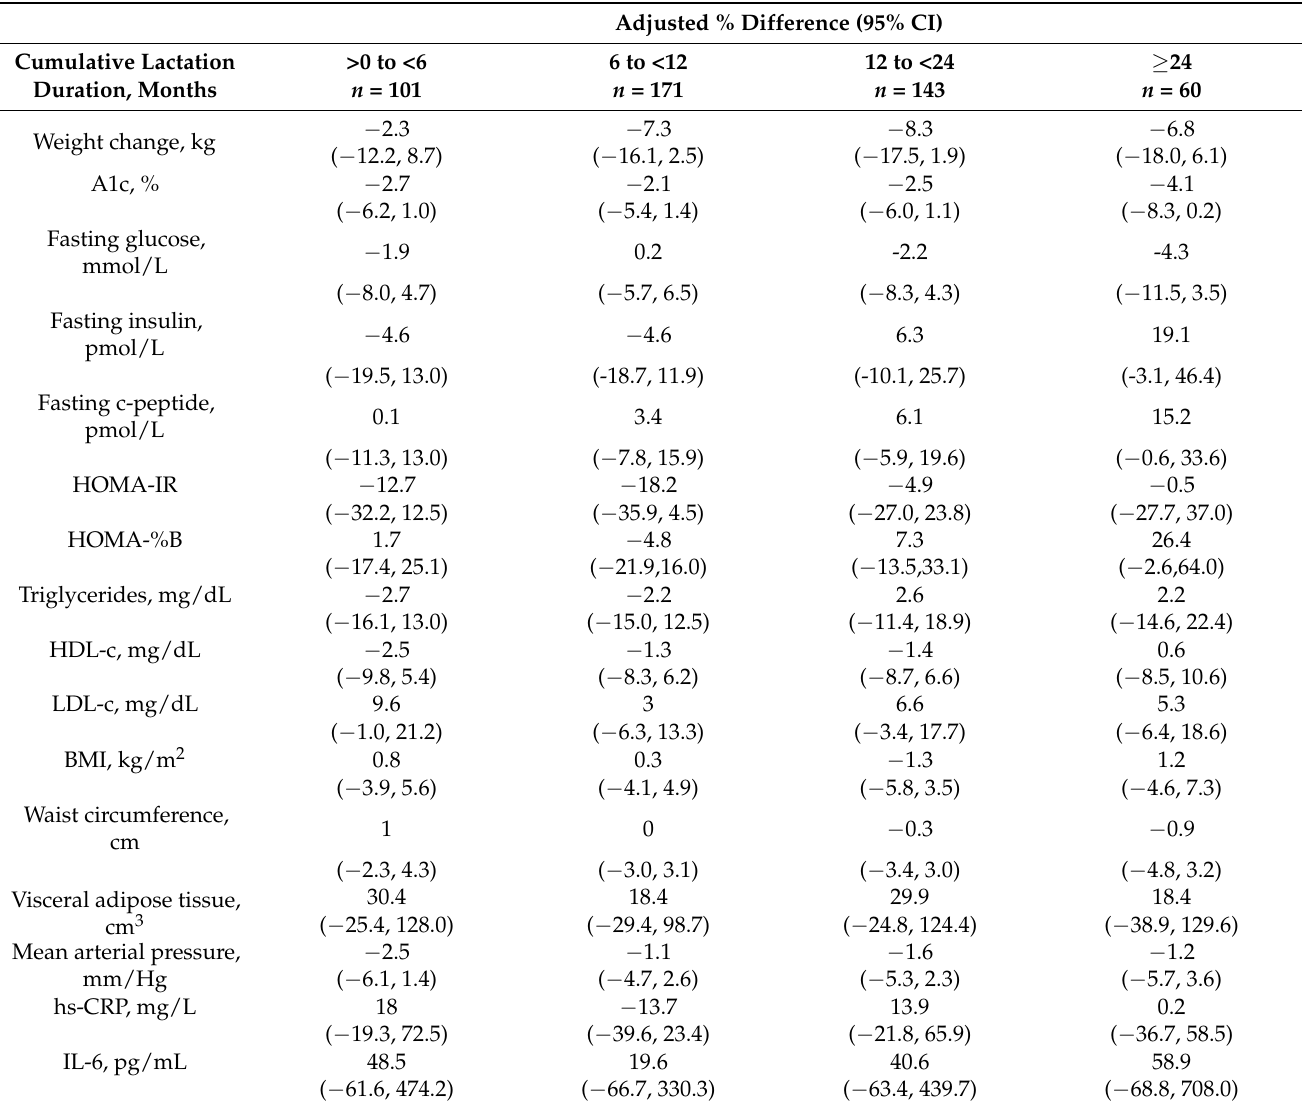
Table 4. Adjusted associations of cumulative lactation duration with continuous cardiometabolic outcomes 9–16 years after the index pregnancy among women with a history of gestational diabetes compared to no lactation, n =